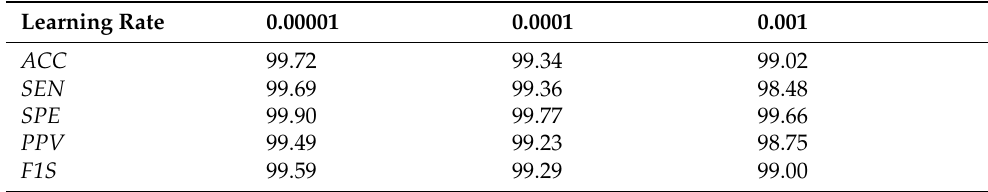
Table 4. Classification evaluation results with the confusion matrix parameters and three different learning rates (in unit %).